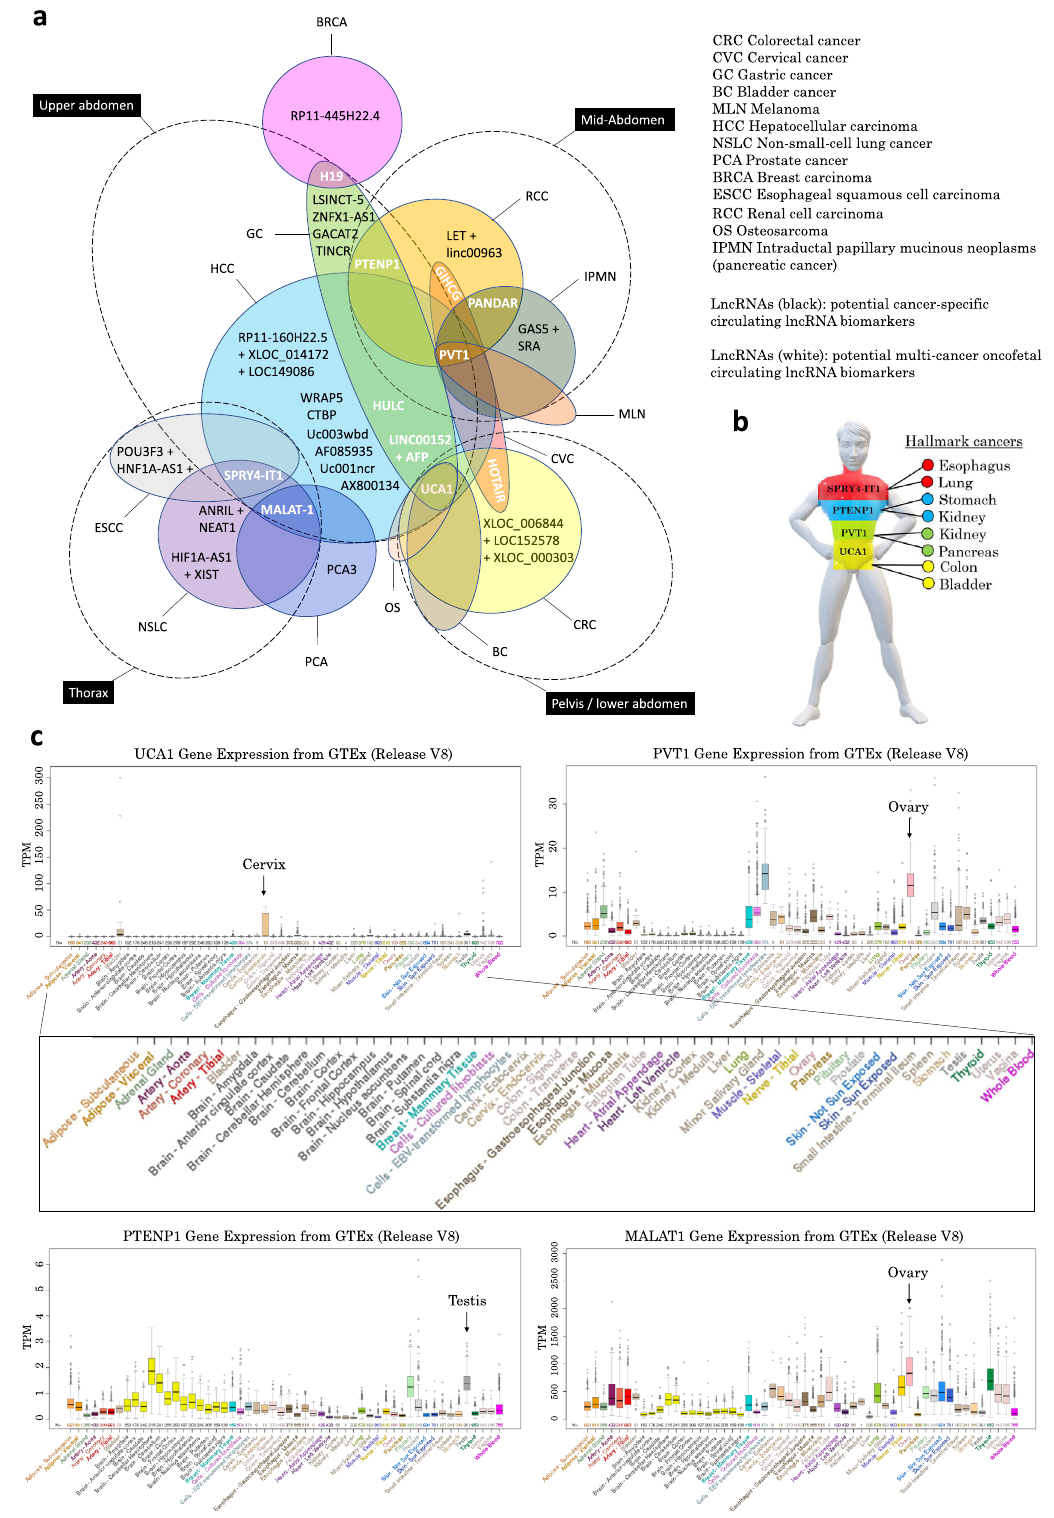
Fig. 2 Cancer-speci fi c and multicancer blood-derived lncRNA biomarkers. a Diagram showing circulating lncRNAs reported in the literature regrouped by cancer type. Some lncRNAs (in black letters) are cancer-speci fi c. Other circulating lncRNAs (in white letters) such as MALAT1, SPRY4-IT1, PVT1, UCA1 and LINC00152 re fl ect tumorigenesis in multiple organs. b Simpli fi ed cartoon representing the speci fi city of certain circulating lncRNAs towards cancers of organs located in designated anatomic segments of the human body. c Gene tissue expression